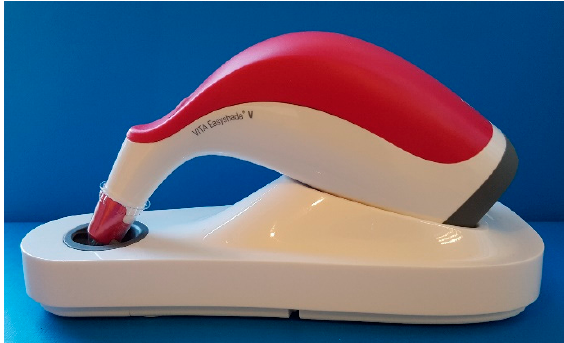
Figure 3. Image of the Vita Easyshade spectrophotometer used in this study.